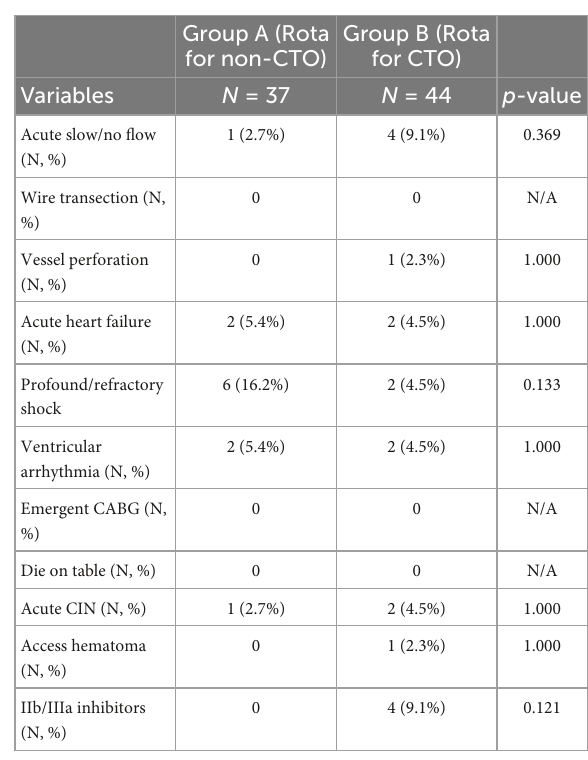
TABLE 3 Incidence of in-procedure complications and acute contrast-induced nephropathy in patients treated with rotablation for CTO and non-CTO